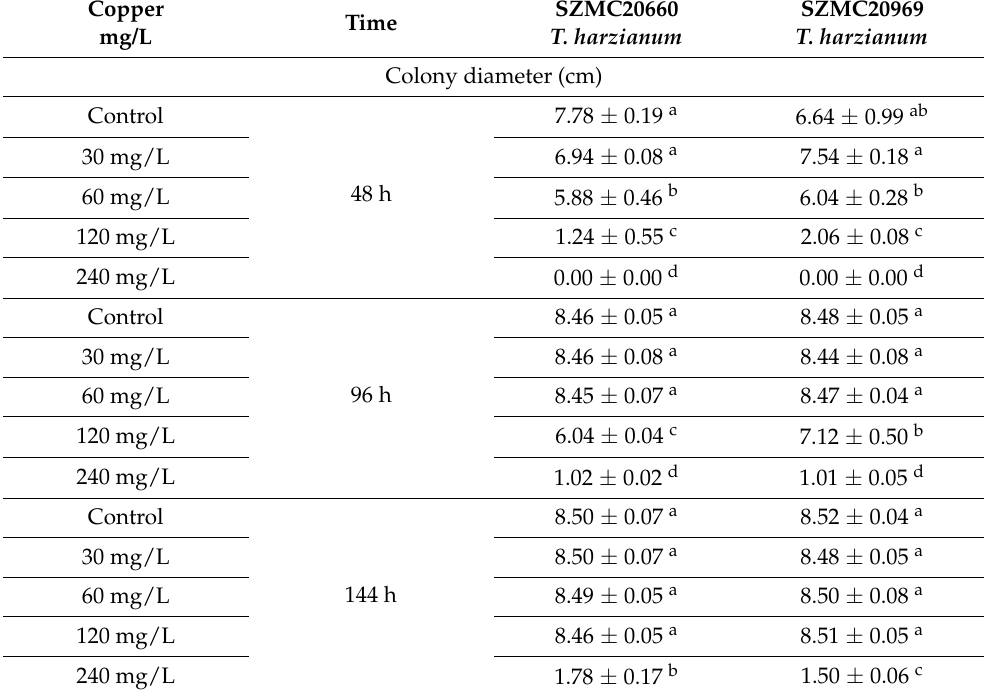
Table 2. Colony diameter of T. harzianum SZMC20660 and SZMC20969 grown on different copper concentrations. Different letters (a, b, c, d) indicate statistically significant differences according to Tukey’s